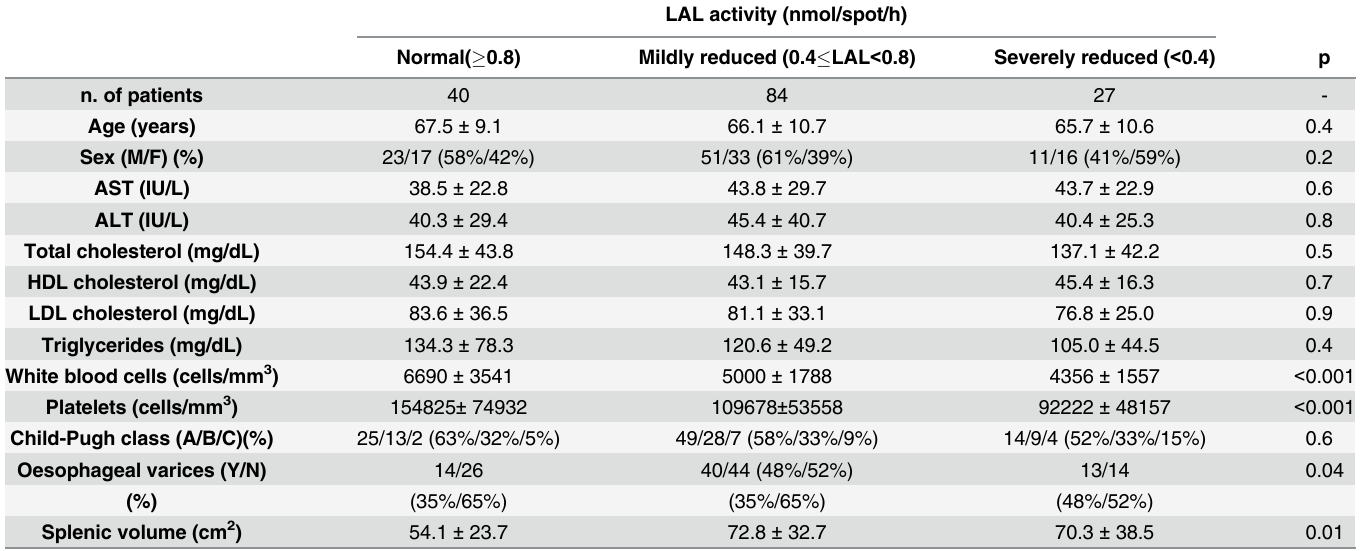
Table 3. Main characteristics of the whole cirrhotic population according to different levels of LAL activity (normal, mildly reduced and severely reduced). LAL activity (nmol/spot/h) Normal( (cid:1) 0.8)